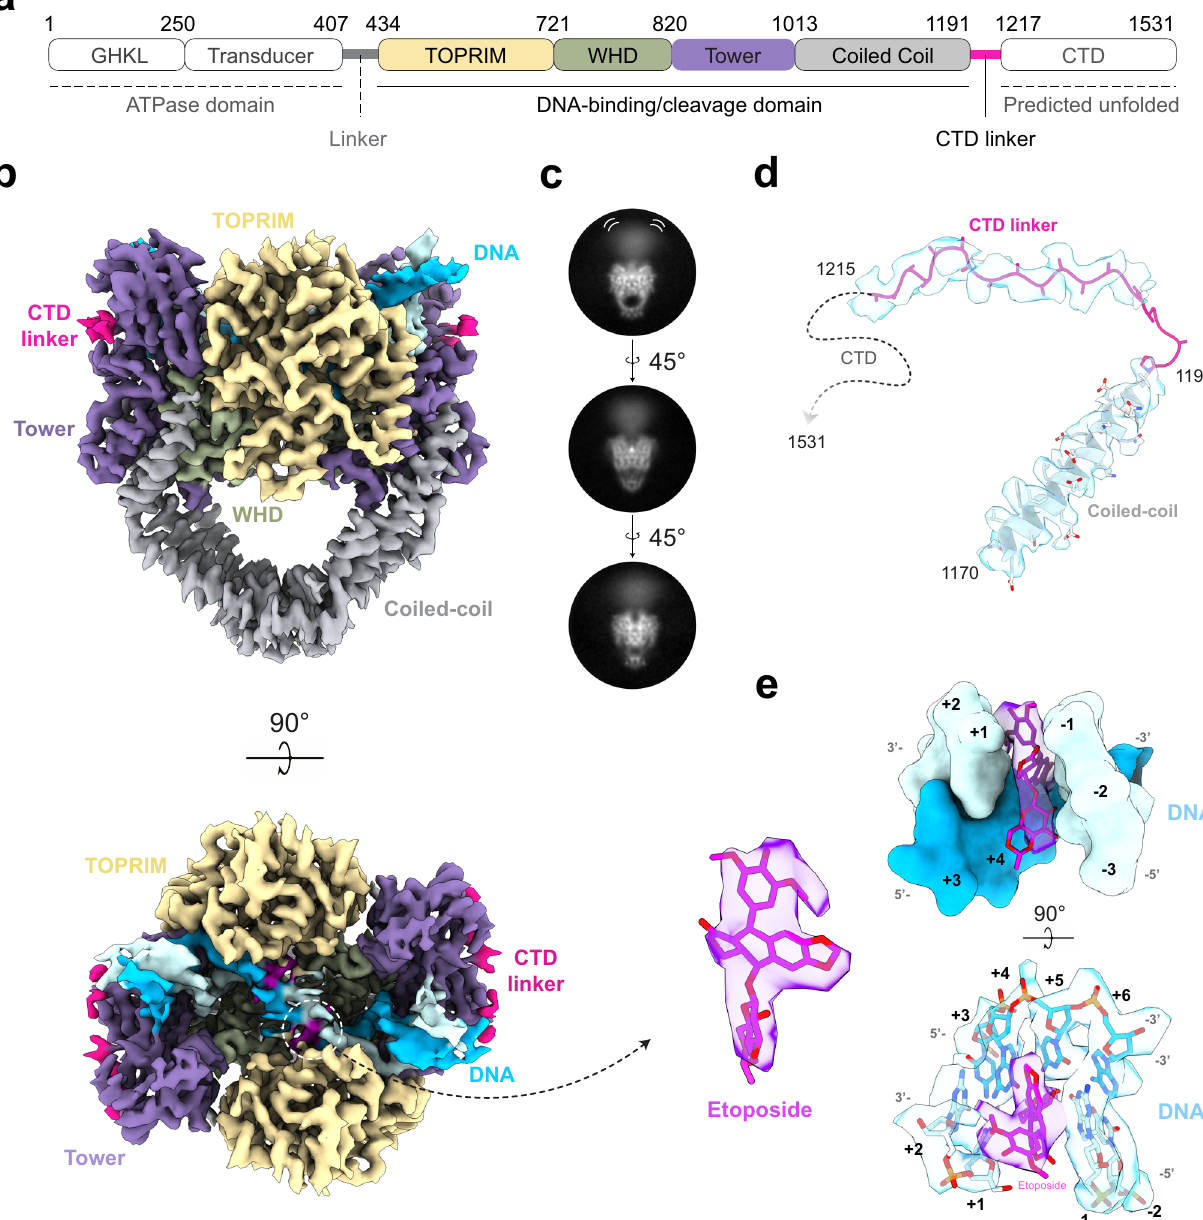
Fig. 1 Cryo-EM structure of the hTopo II α etoposide-poisoned DNA-binding/cleavage domain. a Schematic representation of the hTopo II α DNA- binding/cleavage domain. b Cryo-EM structure of the DNA-binding/cleavage domain in State 1 solved at 3.6 Å resolution. The structure is colored as in a , the DNA is colored in blue. c 2D classes of hTopo II α in different orientations showing the fl exibility of the ATPase domain. d EM density around the last coiled-coil helix and the CTD linker. e Zoom on the EM density of the etoposide and its binding site intercalating DNA bases + 1 and −